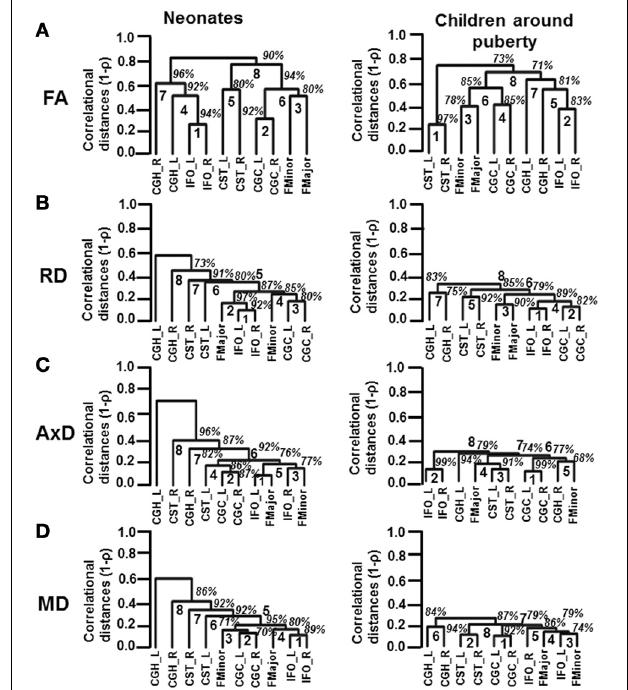
FIGURE 5 | Dendrograms depicting the hierarchical clustering pattern obtained from tract-level FA (A), RD (B), AxD (C) and MD (D) measurements for both age groups. The left and right panels show the clustering pattern for neonates and children around puberty, respectively. The ranks of the clustering are shown in bold. The confidence intervals for the clustering (the percentage values) are shown in